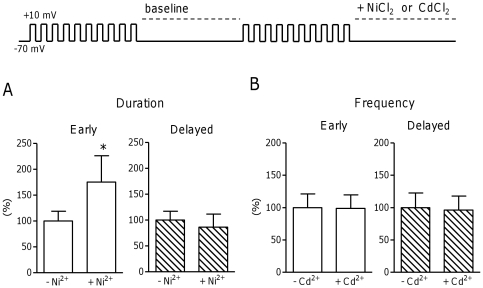
Effect of sarcolemmal fluxes on spark frequency and duration.A. Effect of NCX block by 5 mM nickel on spark frequency and duration in early (left) and delayed (right) release areas in CTRL cardiomyocytes (Npigs = 3, ncells = 7). B. Effect of ICaL block by 50 µM cadmium on spark frequency and duration in early (left) and delayed (right) release areas in CTRL cardiomyocytes (Npigs = 2, ncells = 9). * denotes P<0.05.